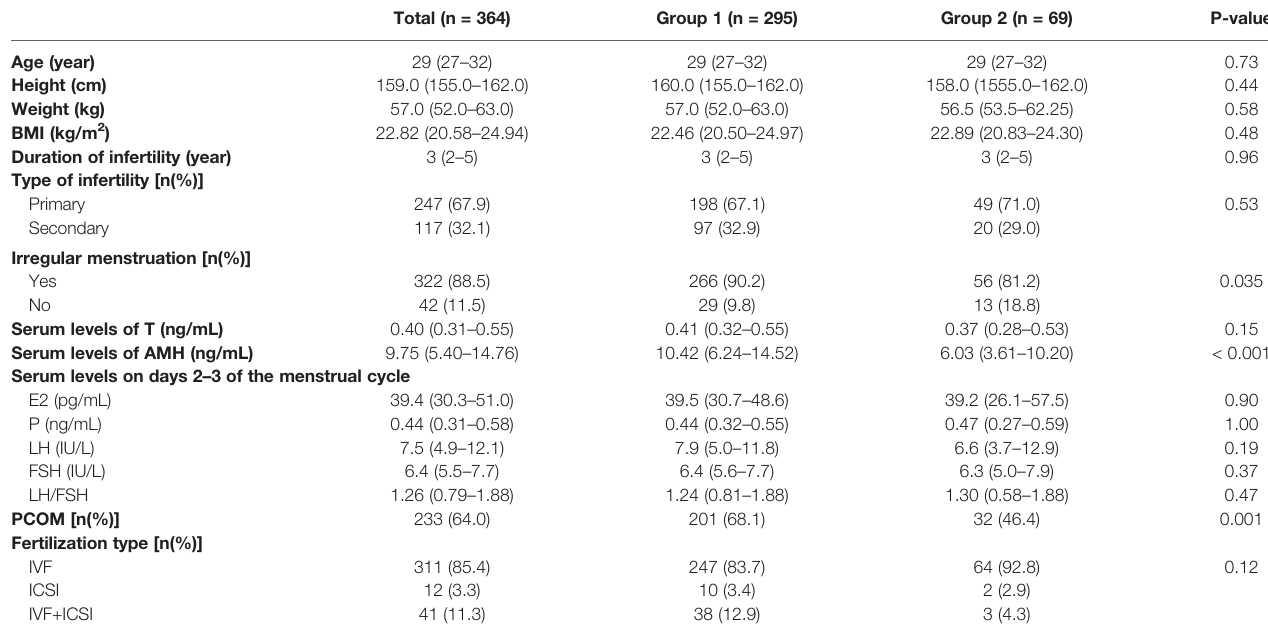
TABLE 1 | Basic information on the patients in this